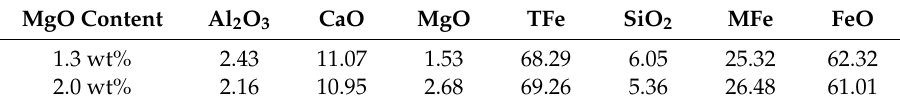
Figure 14. Photos during melting temperature. Table 7. Chemical component at T S (mass fraction) [%].